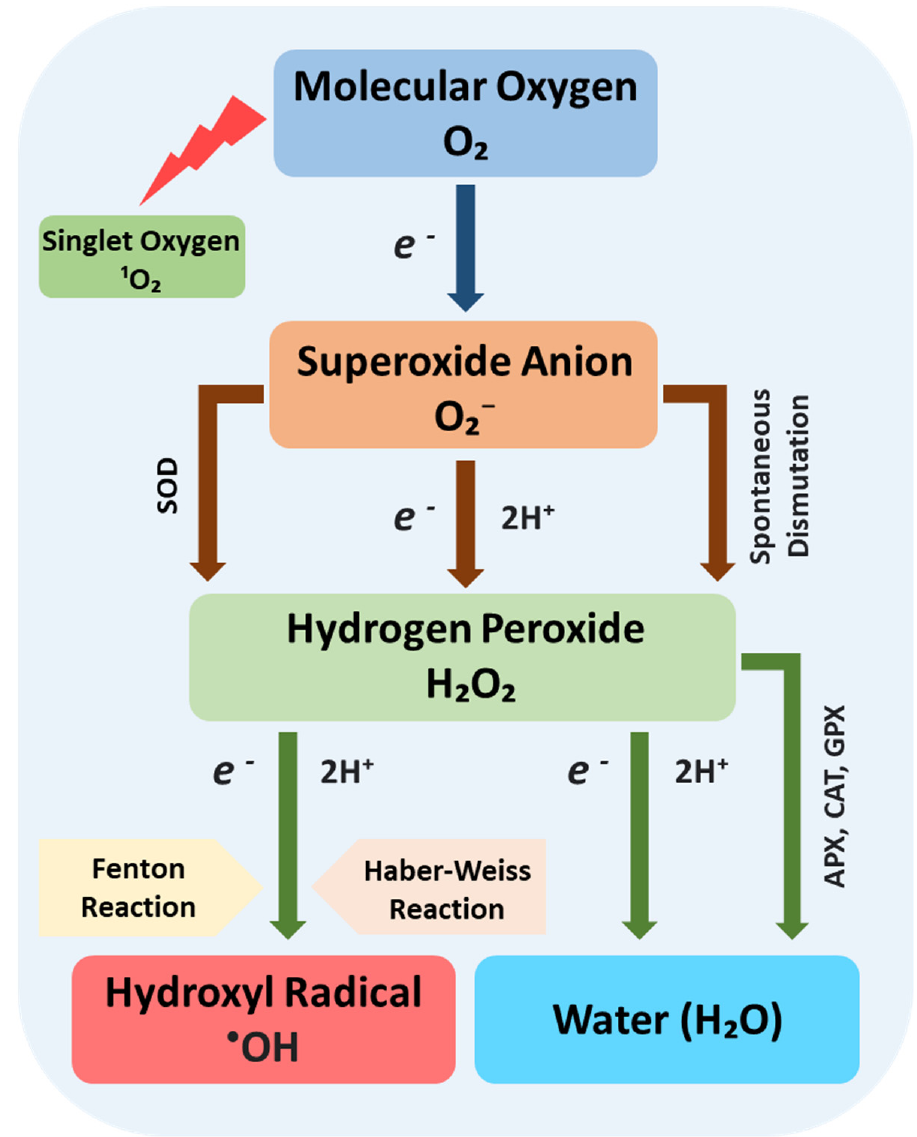
Figure 3. Schematic diagram of ROS production in plants. The concentration of ROS and scavenging capacity of antioxidants in cotton is consid- ered as a selection criterion for heat tolerant accessions [74]. An experiment was conducted using two cotton cultivars, and heat stress was applied gradually from 30 to 45 ◦ C on 30 days old seedlings. The results revealed a 206 to 248% increase in hydrogen peroxide content and a 40 to 170% increase in lipid peroxidation under heat stress conditions. The concentration of non-enzymatic antioxidants also increases with increases in temperature, while the activity of enzymatic antioxidants such as superoxide dismutase (SOD), cata- lase (CAT), peroxidase (POX), and ascorbate peroxidase (APX) increase 56–70%, 37–69%, 43–91%, and 22–27%, respectively. It was concluded that genotypic differences exist in cultivars for ROS production and antioxidants response. Higher levels of antioxidants and lower levels of ROS during high temperature are an indication of heat stress toler- ance [75]. In another study, the cotton plants were grown at two temperature regimes, i.e., 38 and 45 ◦ C. The results indicated non-significant differences in the concentration of hydrogen peroxide at both temperatures, while the concentration of proline decreased rapidly and significantly as the temperature increased from 30 to 45 ◦ C. The activity